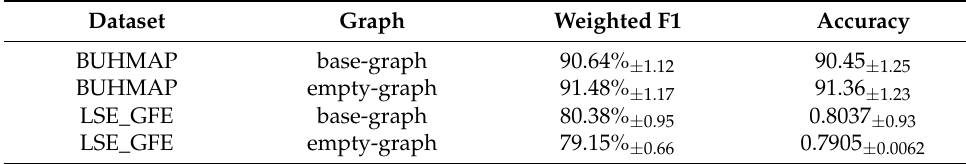
Table 8. Ablation study for graph topology.